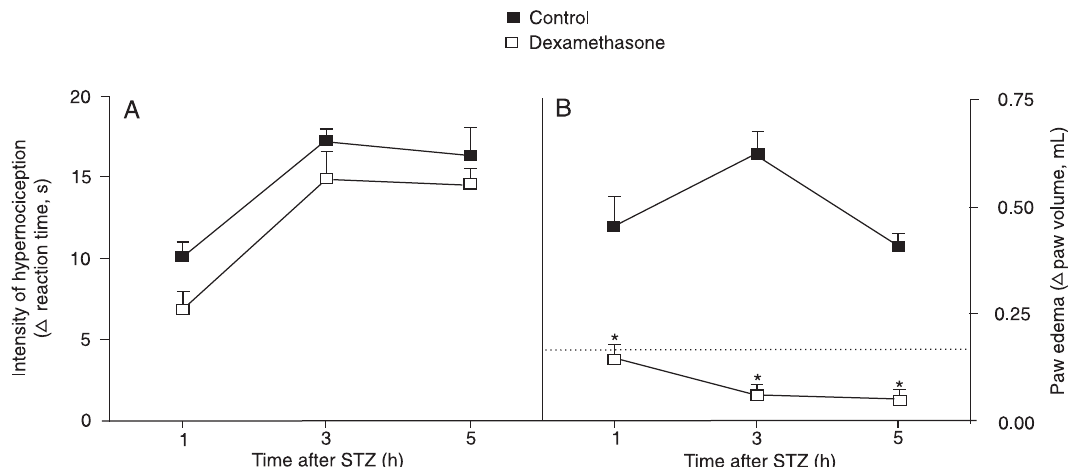
Figure 5. Effect of dexamethasone on hypernociception and edema induced by ipl administration of streptozotocin (STZ). Saline (control groups, sc; 0.25 mL/200 g) or dexamethasone (1 mg/kg, sc) was injected one hour before STZ treatment (100 μ g/paw in 100 μ L) and hypernociception (panel A) or edema (panel B) was measured 1, 3 and 5 h later. The dotted line indicates the paw volume of